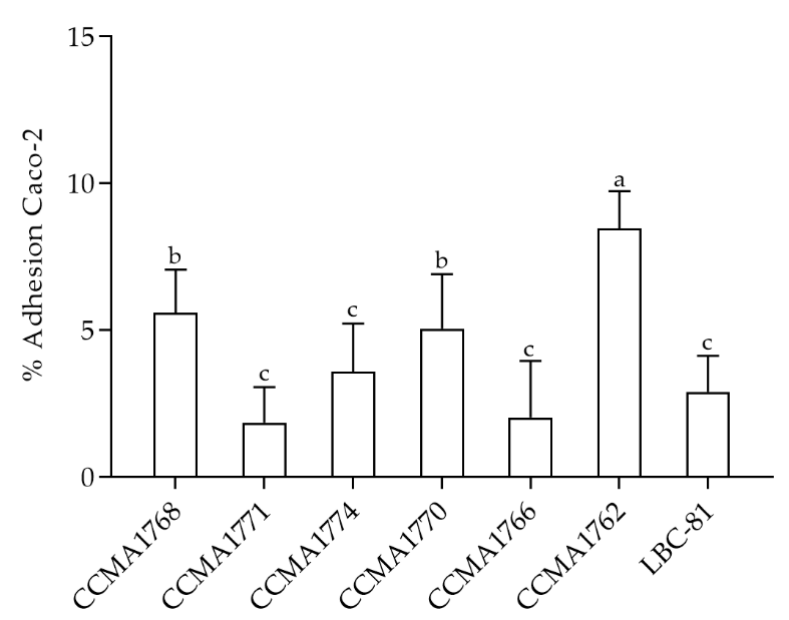
Figure 4. Adhesion capacity of LAB strains to Caco-2 cells. Bar indicates SD. Bars followed by different letters differ significantly ( p < 0.05) by the Scott–Knott test.